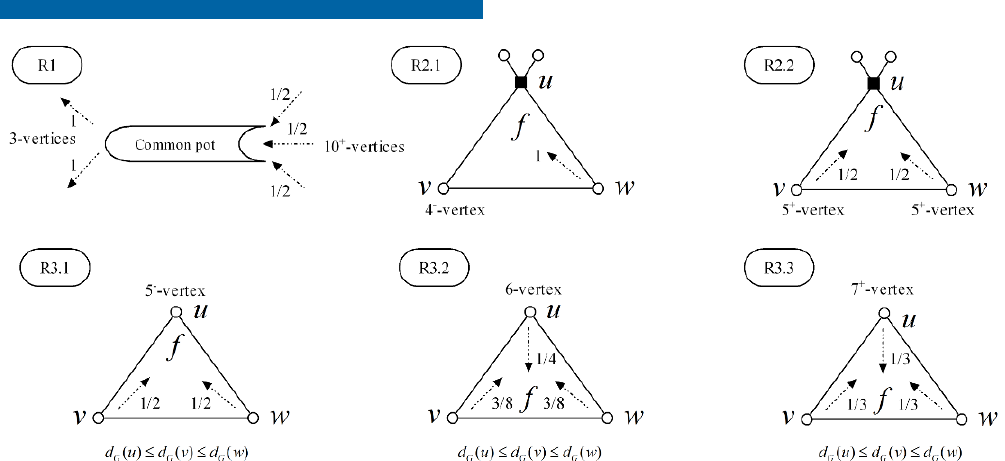
Figure 5. Discharging rules for the proof of Theorem